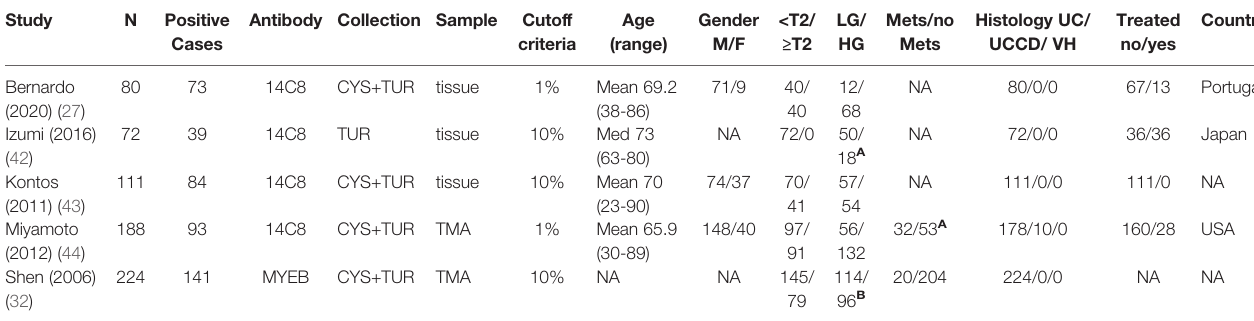
TABLE 2 | Characteristics of the studies included for meta-analysis of ER b expression in BlaCa.